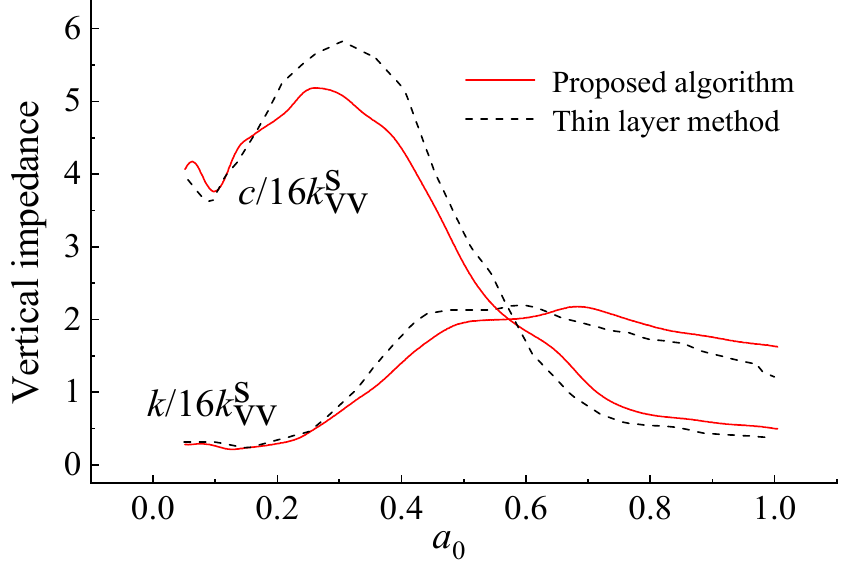
Figure 4. Vertical impedance function of a pile-group foundation compared with the thin layer method.